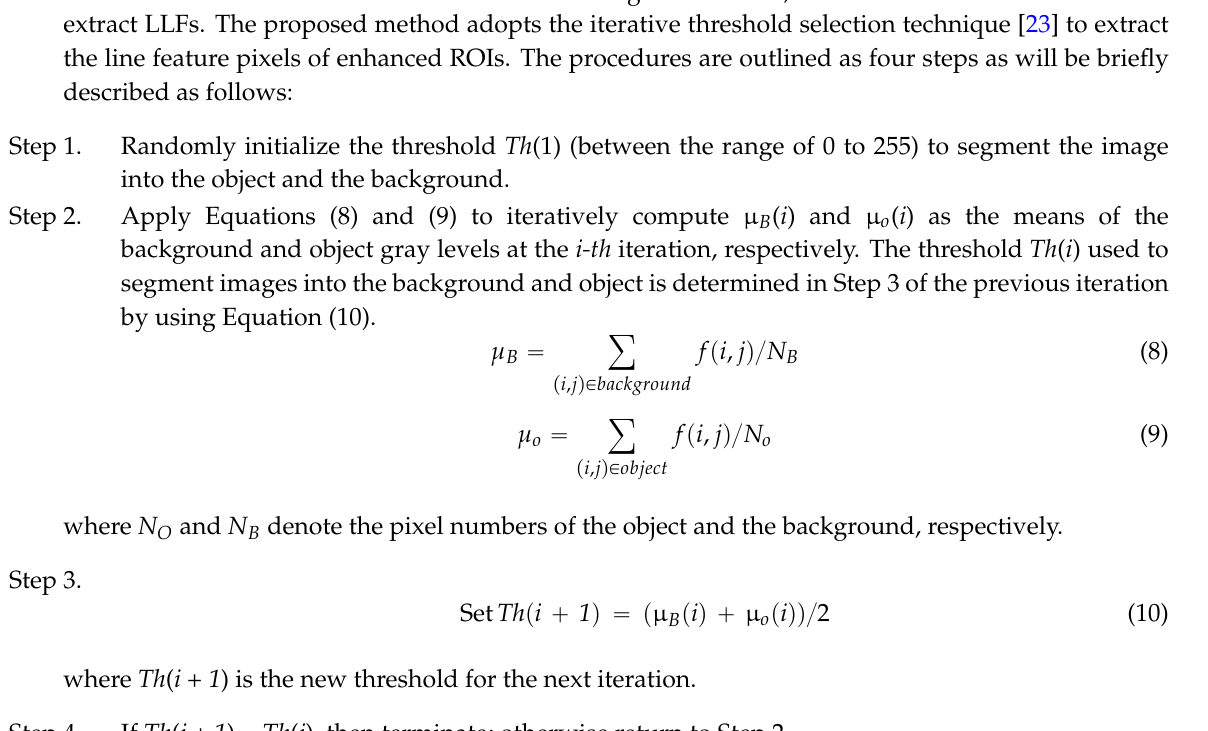
Figure 12. Example illustrating the result from applying a Sobel operator.